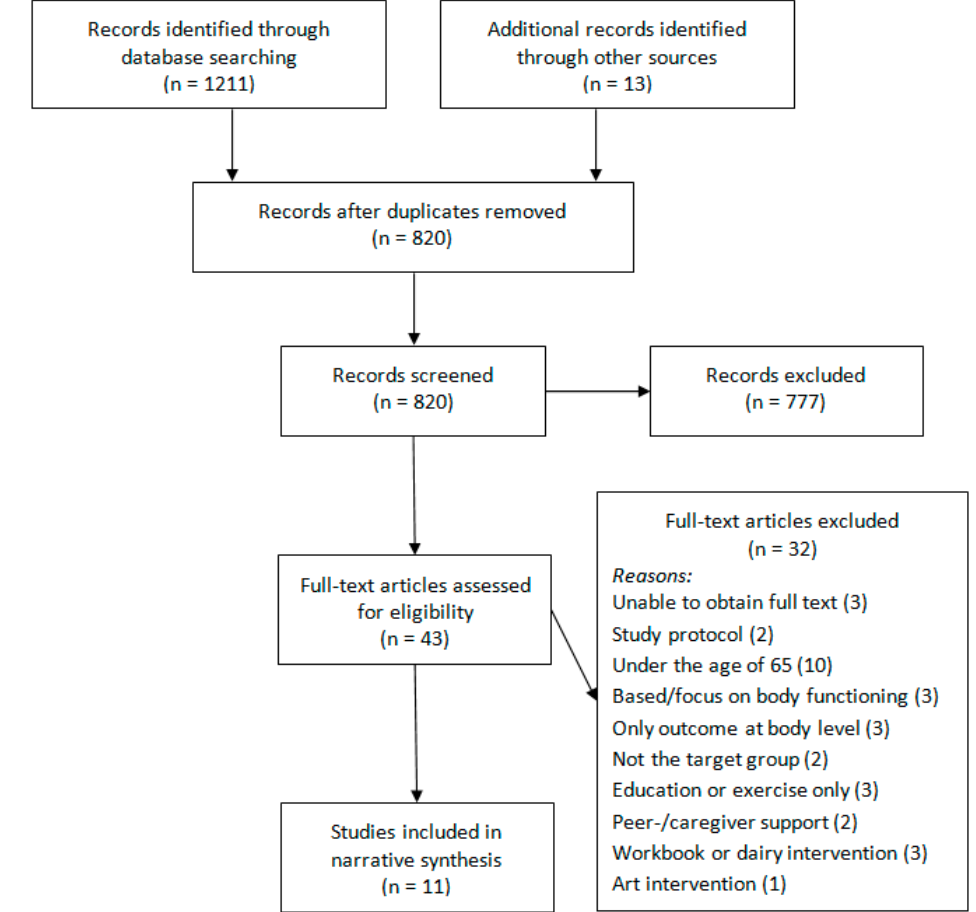
Figure 1. PRISMA flow diagram of study selection.